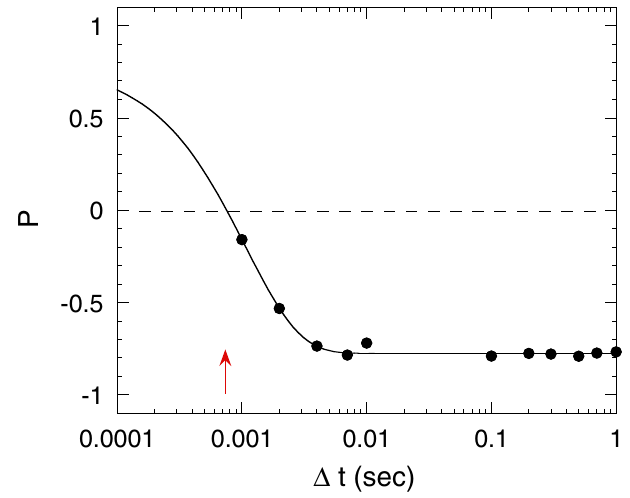
FIG. 1. (Color) Measured proton polarization at 2 : 1 GeV =c is plotted vs rf dipole ramp time (cid:1) t [23]. The rf dipole’s frequency range (cid:1) f was 8 kHz; its R Bdl was 0 : 46 (cid:6) 0 : 03 T mm ; thus, (cid:1) (cid:2) 80 (cid:6) 4 (cid:4) (cid:5) 10 (cid:3) 6 . The fit to Eq. (3) gives Eq. (5) gives E Bdl E FS (cid:1) (cid:2) 580 (cid:6) 10 (cid:4) (cid:5) 10 (cid:3) 6 ; the arrow shows the (cid:1) t where P (cid:1) 0 .